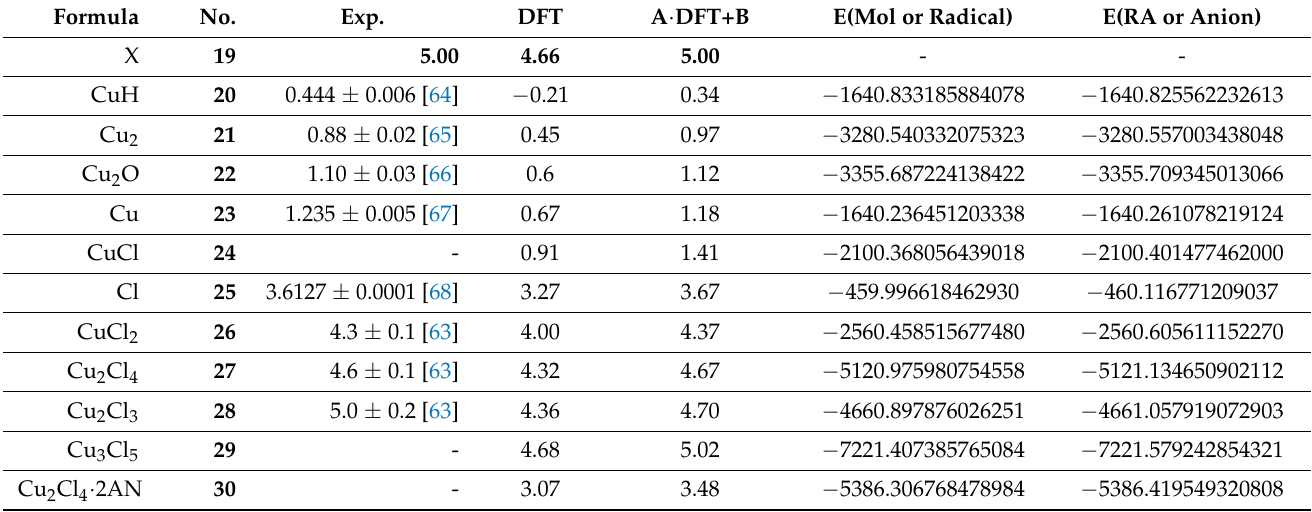
energies (E, E h ) of molecules ( Mol ) or radicals and radical anions ( RA ) or anions of 19 – 30 *.